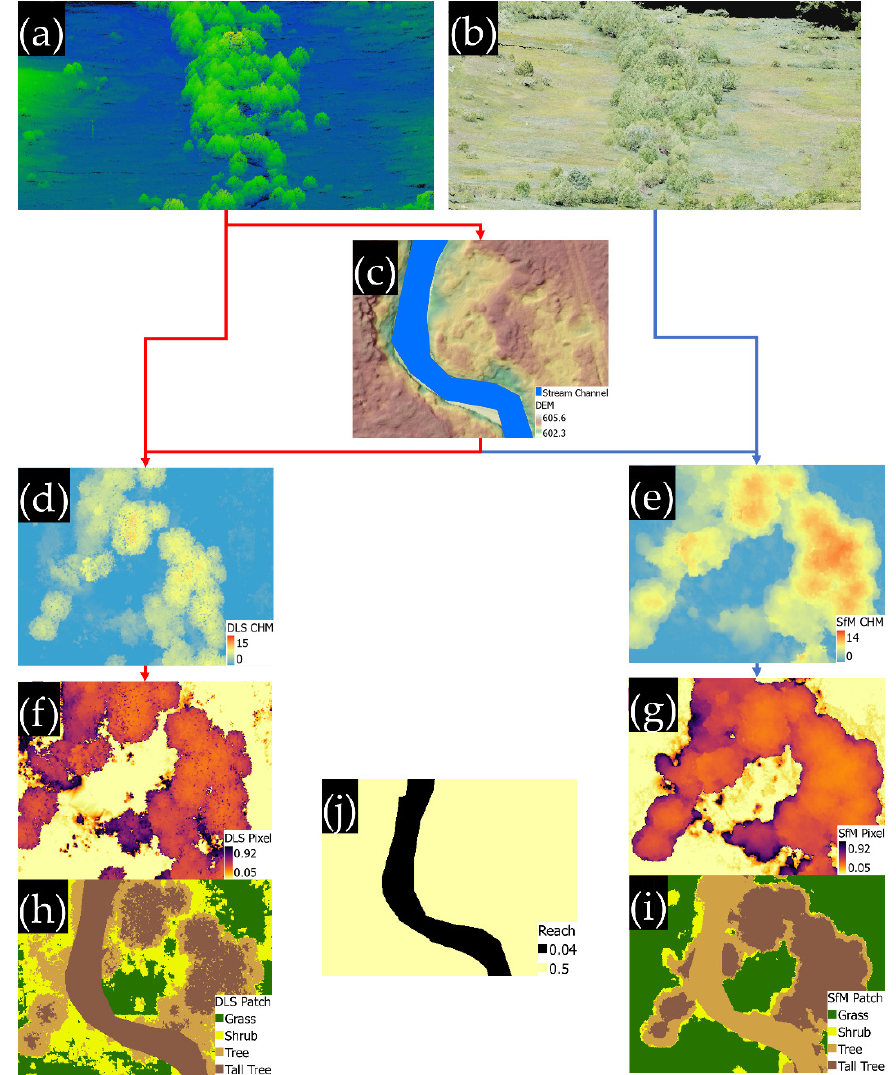
Figure 4. Data visualization workflow: ( a ) DLS point cloud of the study site, ( b ) SfM point cloud of the study site, ( c ) DEM derived from the DLS point cloud at a meander bend, ( d ) DLS CHM, ( e ) SfM CHM, ( f ) roughness raster from the pixel method using DLS, ( g ) roughness raster from the pixel method using SfM, ( h ) roughness raster from the patch method using DLS, ( i ) roughness raster from the patch method using SfM, ( j ) roughness raster from manually assigned floodplain and channel roughness values.